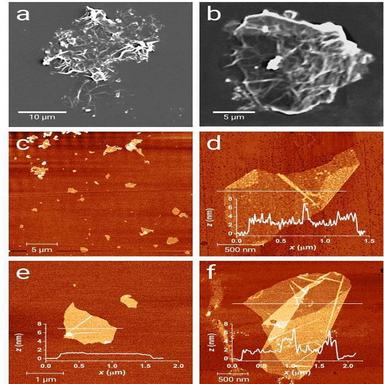
(a)-(b) SEM and (d)-(f) AFM representative images of GO nanosheets.